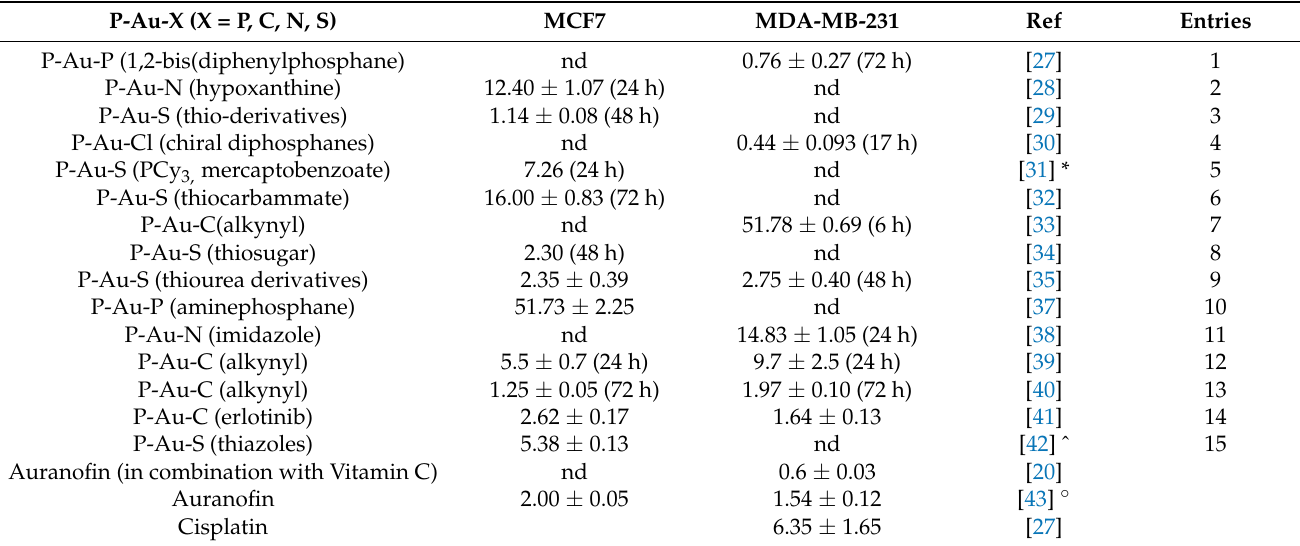
Table 1. IC 50 for selected phosphane gold(I) compounds on breast cancer cell lines. The active compounds are quoted mentioning their coordination chemical environment at the gold(I) center while the structures are shown in Scheme 2 labeled with the relative entries.